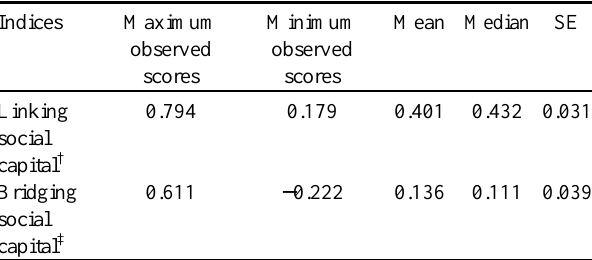
Table 2 . Linking and bridging social capital levels.